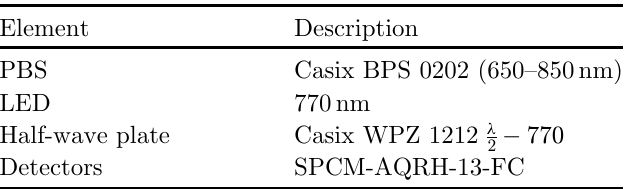
Table 2. Description of the optical components used in the